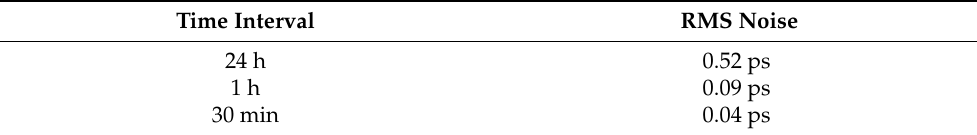
Figure 14. Zoom of 30 min of the delay measurement in a stable room. Table 2. RMS Noise values.